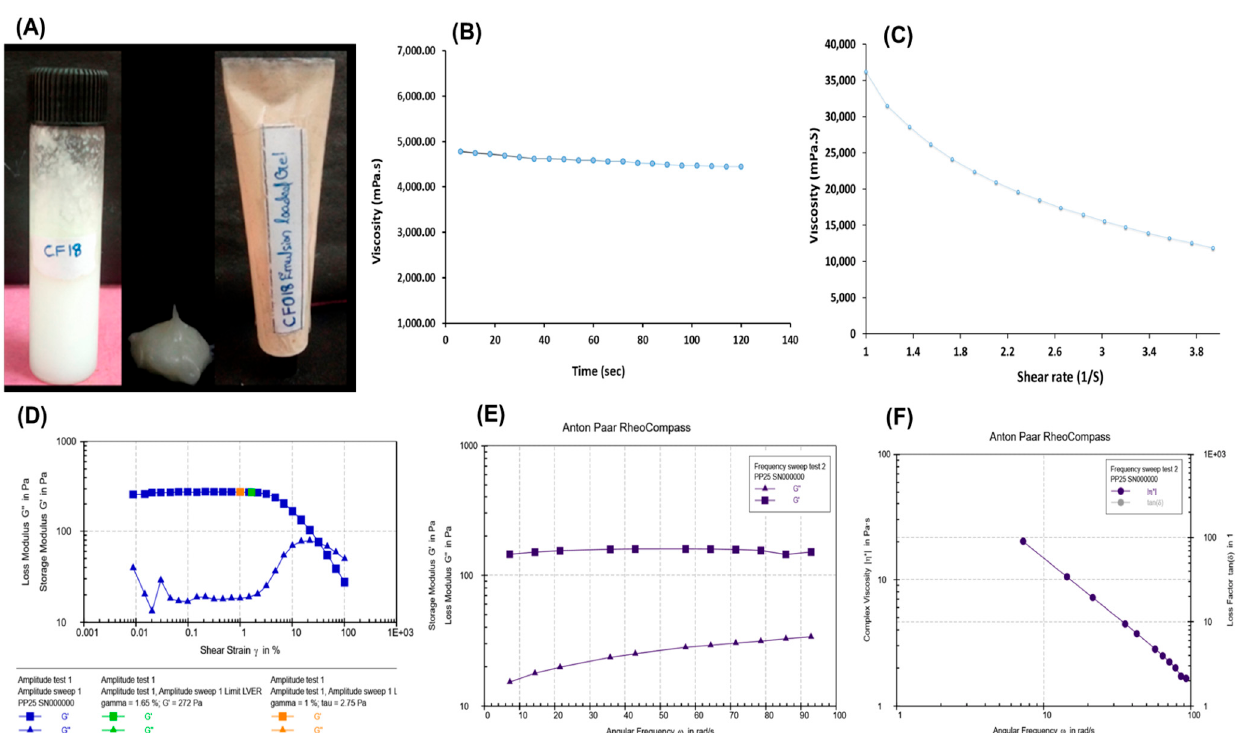
Figure 8. Rheological characteristics of CF018 emulgel. ( A ) CF018 emulsion and CF018 emulgel formulation( B ) Viscosity. ( C ) Shear flow. ( D ) Amplitude sweep test of formulation employing angular frequency. ( E ) FST of CF018 emulgel (loss modulus and storage modulus). ( F ) FST of CF018 emulgel (complex viscosity) .